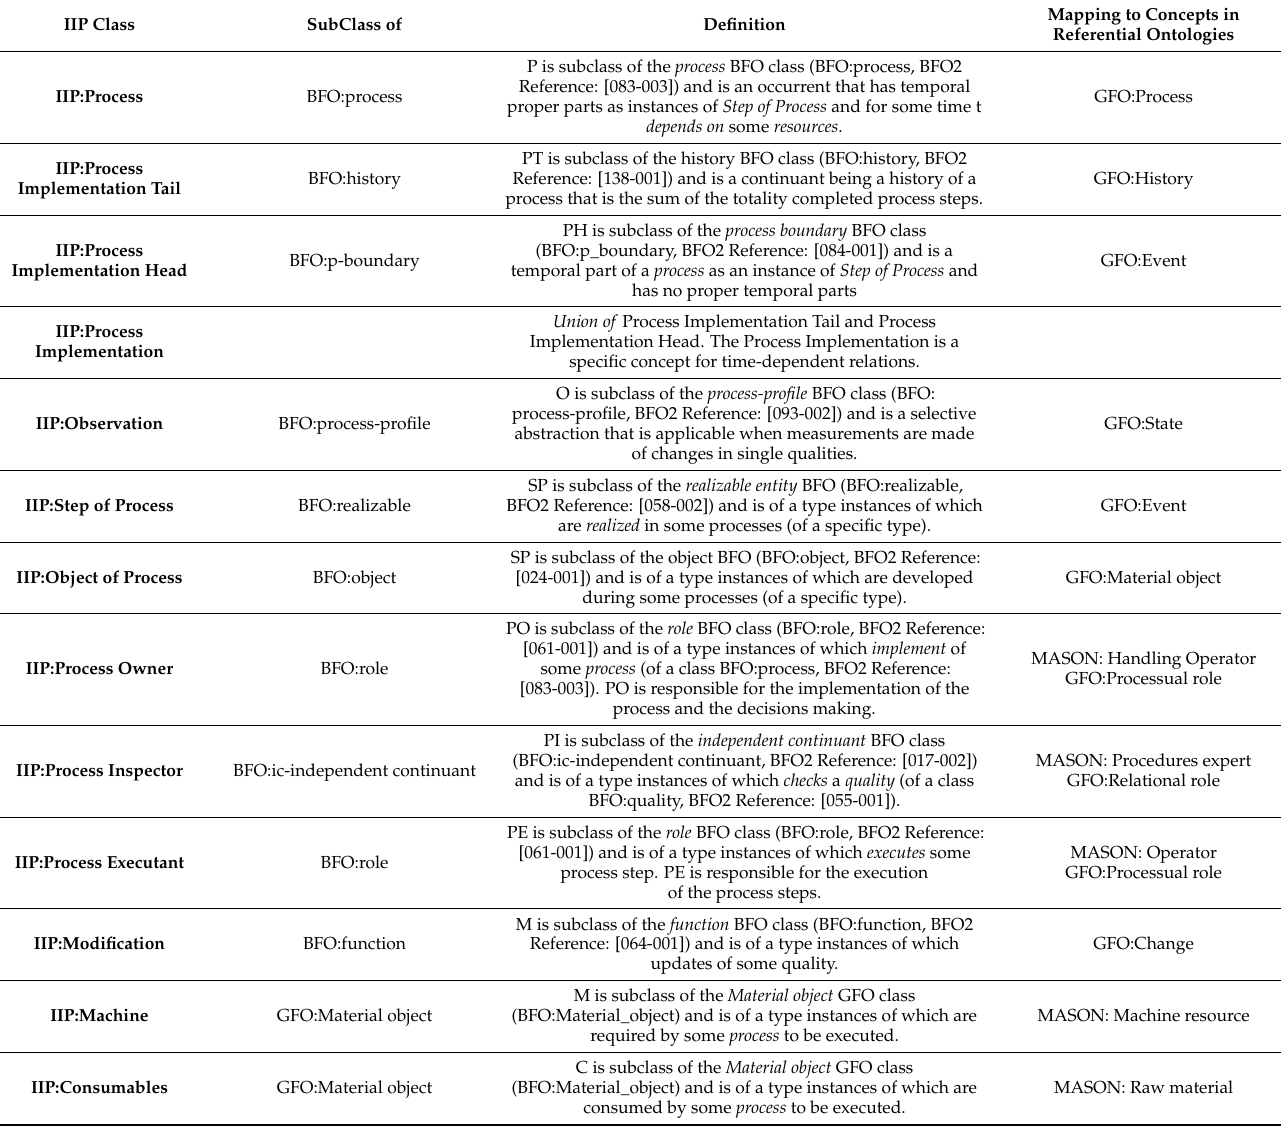
Table 1. The list of key classes of the Semantic reference model for individualization of information